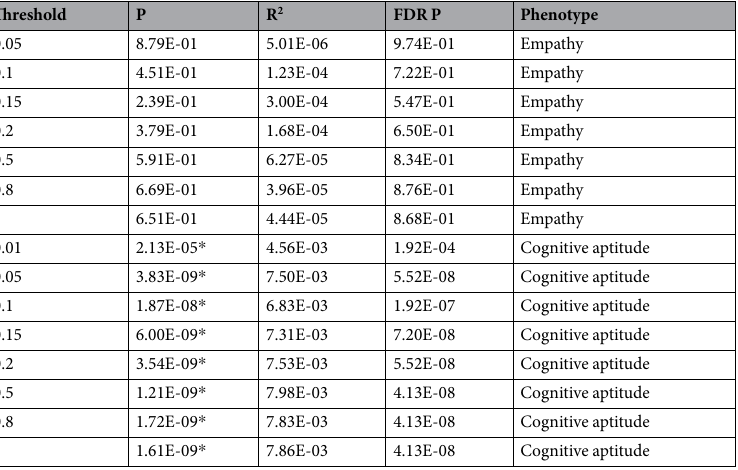
Table 1. Results of the Polygenic score analyses. * Indicates significant polygenic score association after Bonferroni correction (P < 6.94 × 10 − 4